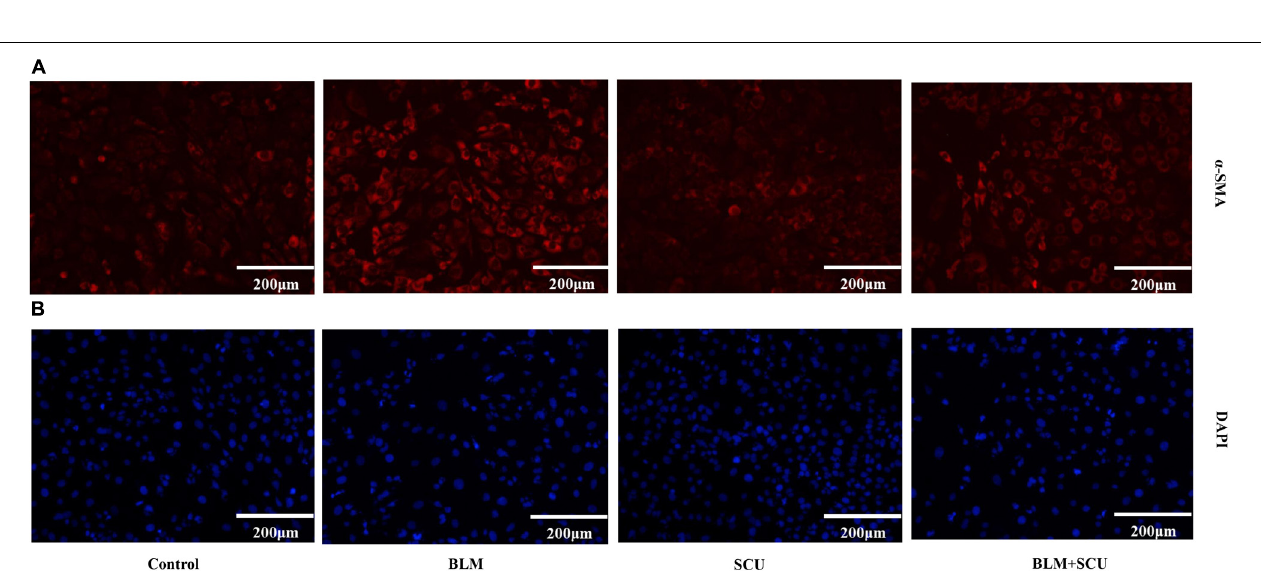
FIGURE 8 | Effects of SCU, BLM, and their combination on the MPO (A) , MDA (B) levels in lung tissue of H22 tumor-bearing mice. Data are shown as the mean ± SD. ( n = 8). # p < 0.05 compared with model group; ∗ p < 0.05 compared with BLM group.